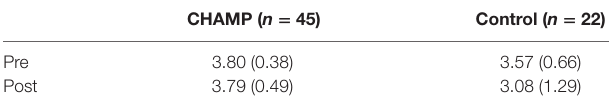
TaBle 3 | Full descriptive statistics for delay of gratification.